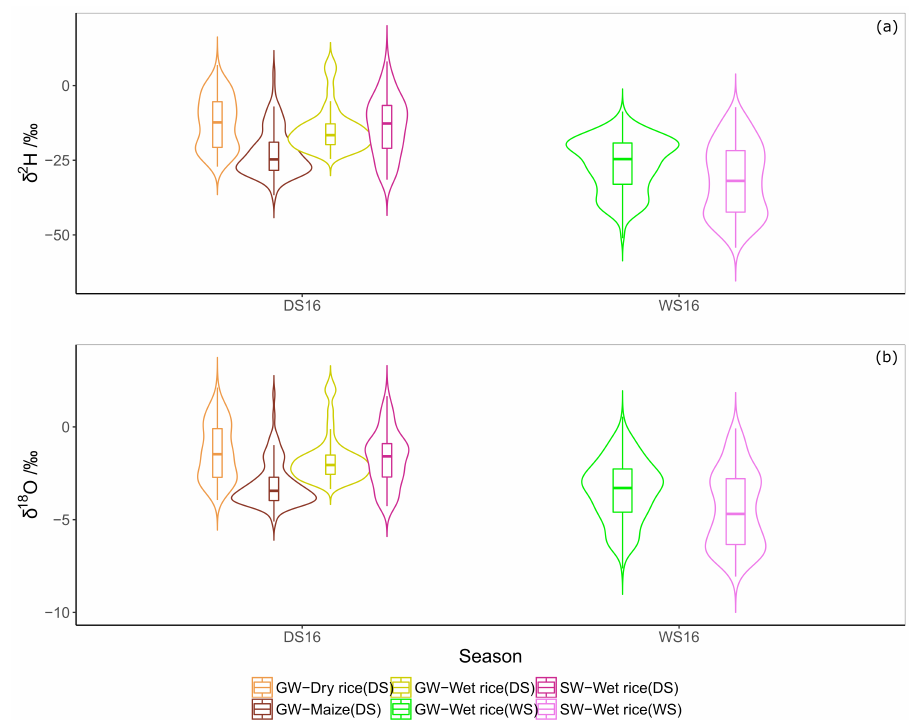
Figure 4. Violin plots of isotope values from lab data (manually collected samples) for δ 2 H ( a ) and δ 18 O ( b ) of groundwater (GW) and surface water (SW) from various fields cultivated with maize, wet rice, and dry rice during the dry season (DS) and wet season